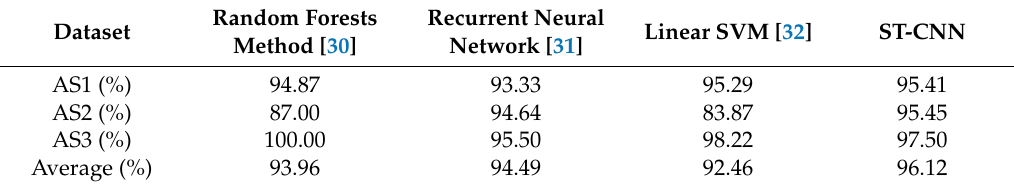
Table 3. Recognition rates for various methods on the MSR-Action3D